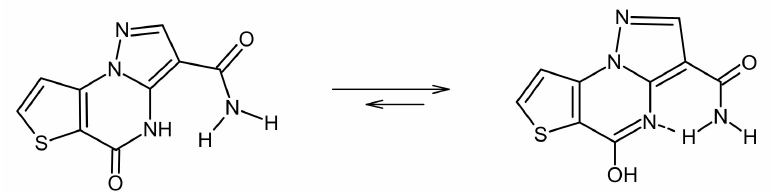
Figure 4. A possible explanation for